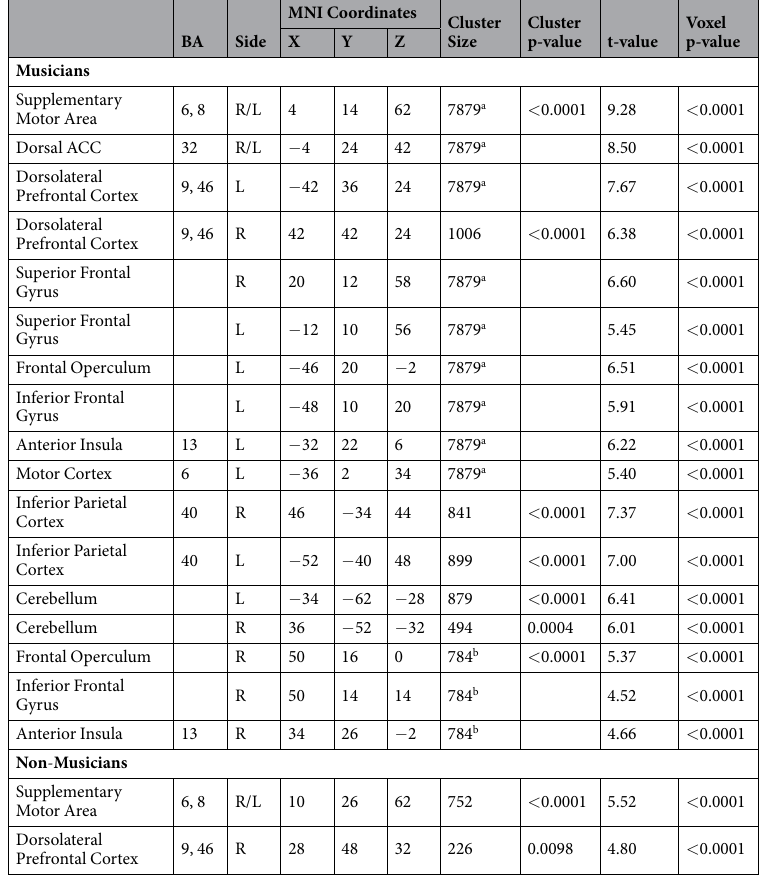
Table 3. Brain regions showing significant within-group activations in the “Improvise > Repeat” contrast. ACC, Anterior Cingulate Cortex; BA, Brodmann Area; R, Right; L, Left; a,b indicates part of the same cluster. All results survived the Alphasim correction for multiple